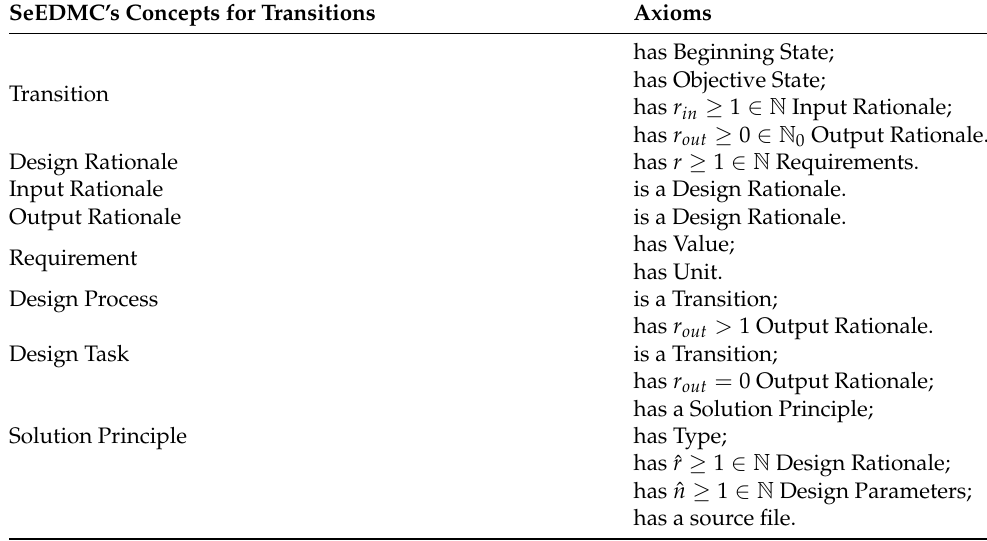
Table 2. Axioms for